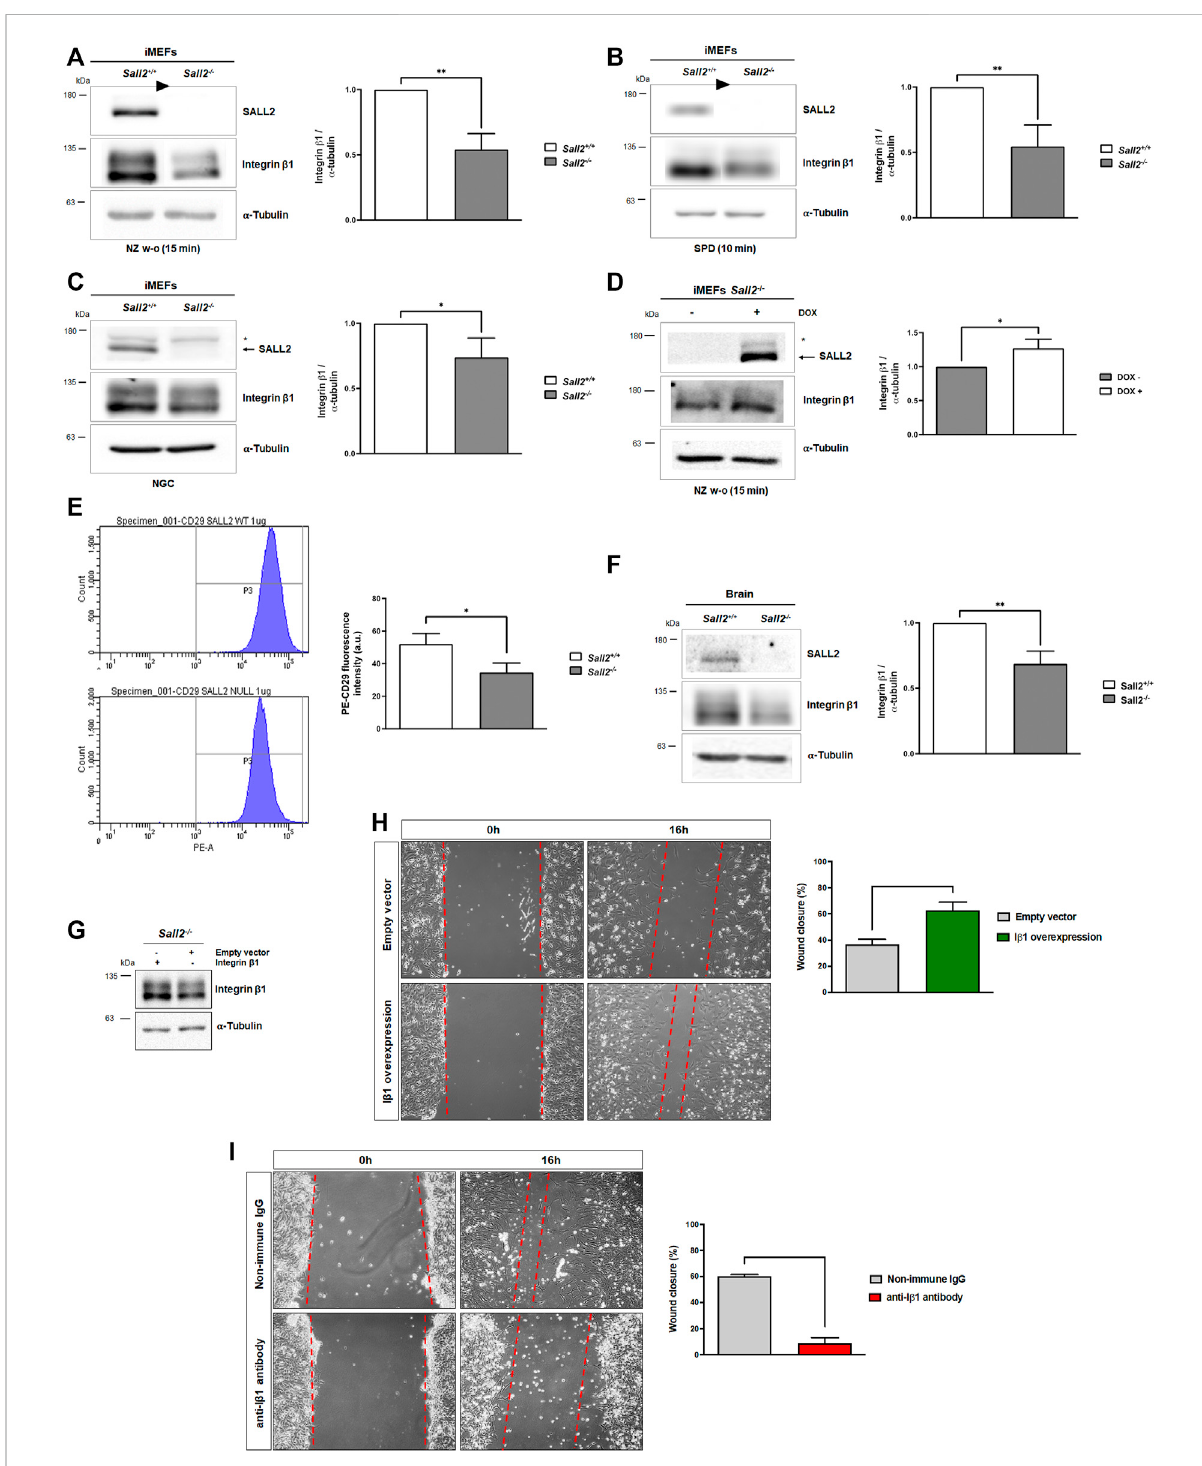
FIGURE 5 Sall2 promotes integrin β 1 expression. (A – C) Representative blots of integrin β 1 expression, and densitometric quanti fi cation, from Sall2 +/+ and Sall2 − / − iMEFsafter15 minofnocodazolewash-outtreatment(NZw-o) (A) ,10 minofcellspreading(SPD)onFN (B) ,andinnormalgrowthconditions (NGC) (C) . (D) Representativeblotofintegrin β 1proteinlevel,anddensitometry,fromtheTet-OnSall2iMEFsinduciblemodelafter15 minofNZw-o. (E) Flow cytometry analysis of the cell surface expression of integrin β 1 from Sall2 +/+ and Sall2 − / − iMEFs. (F) Left, a representative blot of brain tissues from 6 to 8-week-old Sall2 +/+ and Sall2 − / − mice. Right, integrin β 1 densitometry from brain tissues. The arrow indicates Sall2, and the asterisk